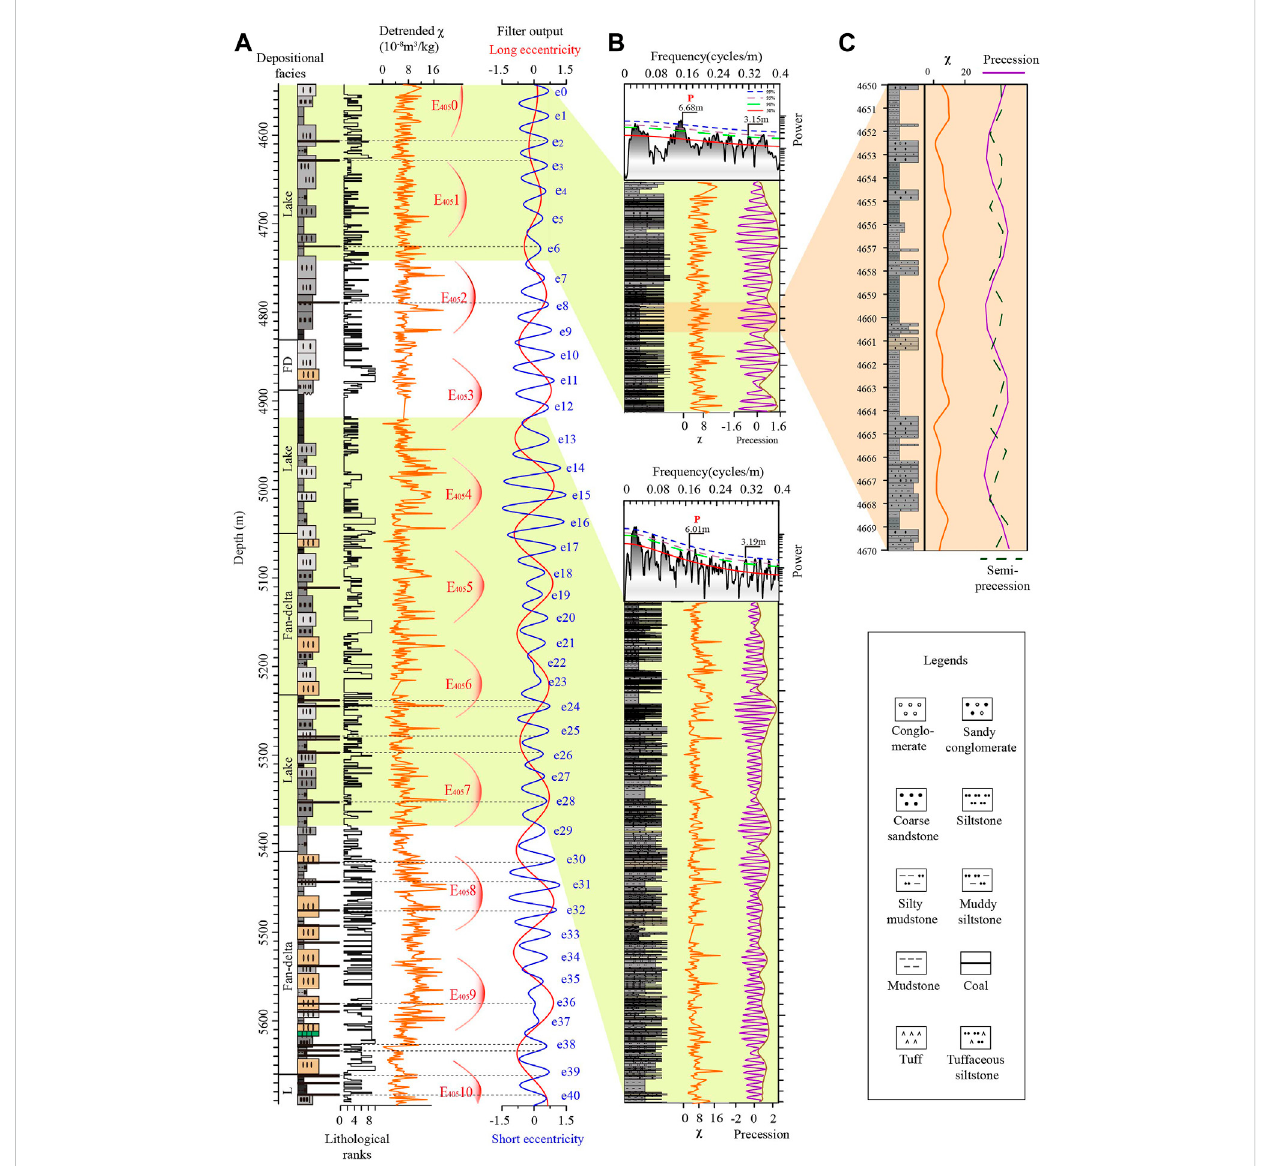
FIGURE 9 (A) Depositional facies, lithological ranks, and χ data in depth domain of the lower K 1 sh, with the interpreted 405-kyr and 100-kyr cyclic signals. The Gaussian bandpass fi lters set for the interpreted 405-kyr (red) and 105-kyr (blue) cycles were 0.009 ± 0.002 cycles/m and 0.035 ± 0.007 cycles/m, respectively.Red “ E 405 ” represents405-kyrlongeccentricity,blue “ e ” represents~105-kyrshorteccentricity (B) Upperpart:2 π MTMpowerspectrumand the precession signals in 4,542 – 4,740 m interval with its amplitude modulation, the interpreted precession cycles (purple) were extracted with a passband of 0.15 ± 0.007 cycles/m; lower part: 2 π MTM power spectrum and the precession signals in 4,918 – 5,380 m interval with its amplitude modulation, precession cycles (purple) were extracted with a passband of 0.166 ± 0.003 cycles/m (C) The precession and semi-precession cycles of χ data of 4,650 – 4,670 m interval. Passband width of precession cycles (solid purple) was the same as (B) , passband of 0.319 ± 0.003 cycles/m was applied to obtain the semi-precession cycles (dashed green). The yellow shades represent 4,542 – 4,740 m and 4,918 – 5,380 m intervals, the sand shades represent 4,650 – 4,670 m interval. Black dashed lines associate the coal seams with the 105-kyr fi ltering